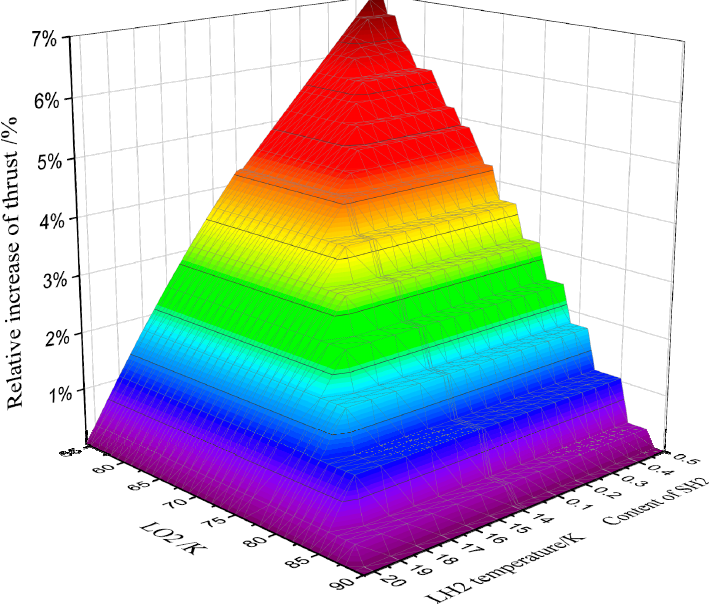
Figure 13. Relationship between LH2/LO2 densification degree and relative thrust increase. Under ideal conditions, in order to avoid the waste of subcooling energy of LO2 and ensure the full and safe combustion of LH2, there is an optimal matching subcooling temperature of LH2/LO2, as shown in Figure 14. It can be clearly seen from Figure 14 that the optimal subcooling temperature of densified LH2/LO2 corresponds one by one after giving the engine volume flow and combustion mixture ratio. When the slush hydrogen with a solid content of 45% is used, the LO2 needs to be subcooled to 54.5 K, which is already connected to the triple point temperature of LO2. For further densification of LH2, a higher density of LO2 is also required, otherwise, the combustion mixing ratio will be reduced due to insufficient LO2.